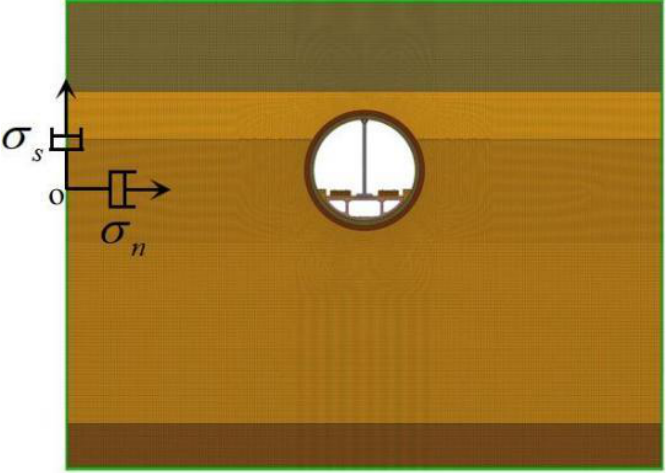
Figure 3. Schematic diagram of two-dimensional viscous artificial boundary.